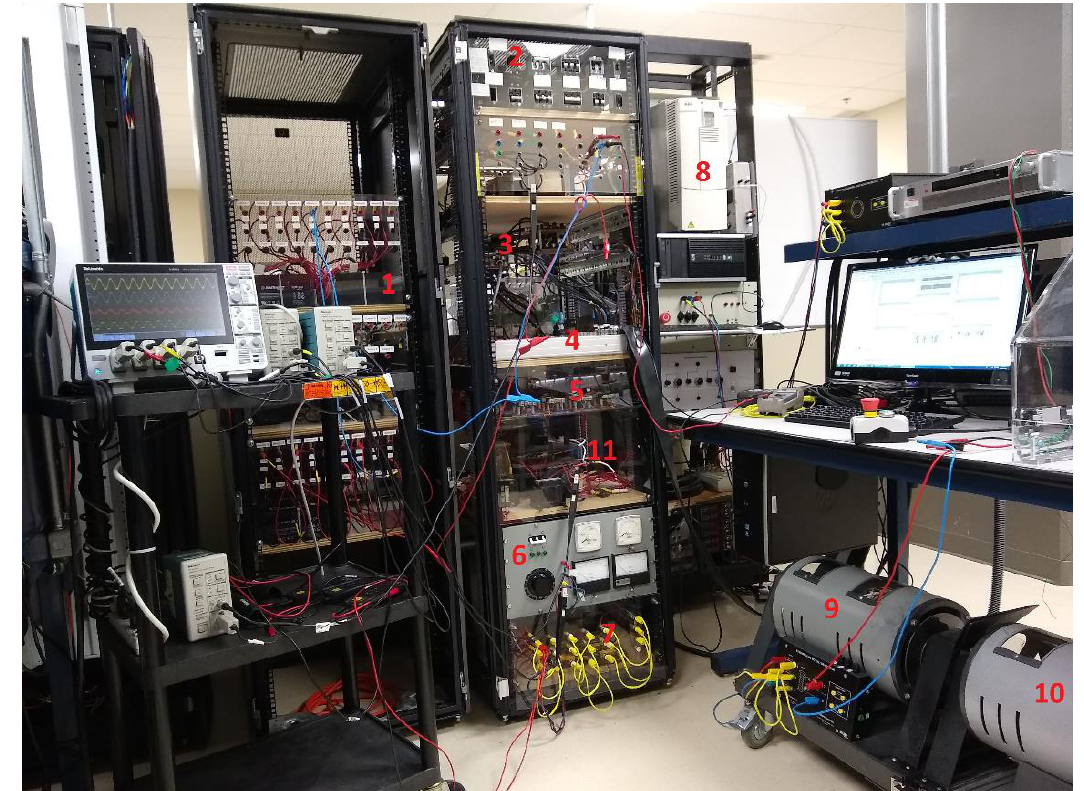
Figure 11. Hardware prototype.